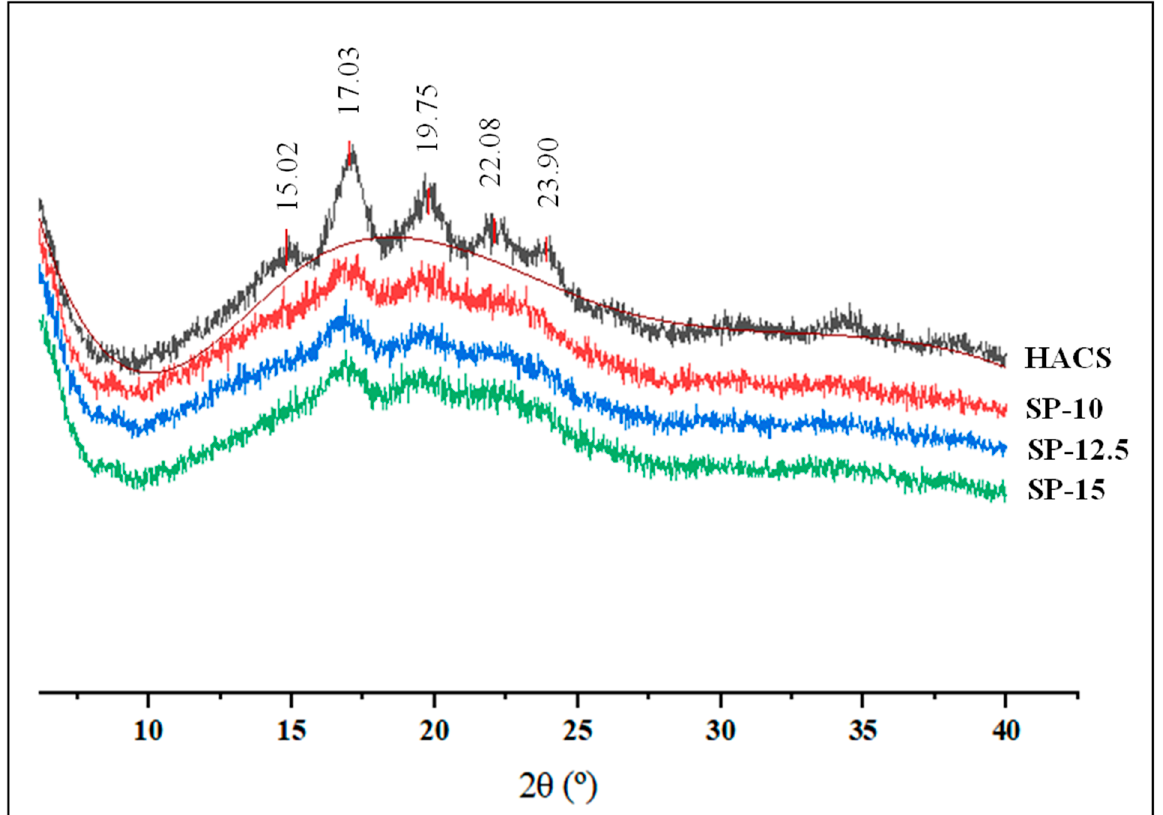
Figure 7. XRD patterns of the HACS and 3D-printed starch beads produced using starch concentrations of 10, 12.5, and 15% ( w / w ).